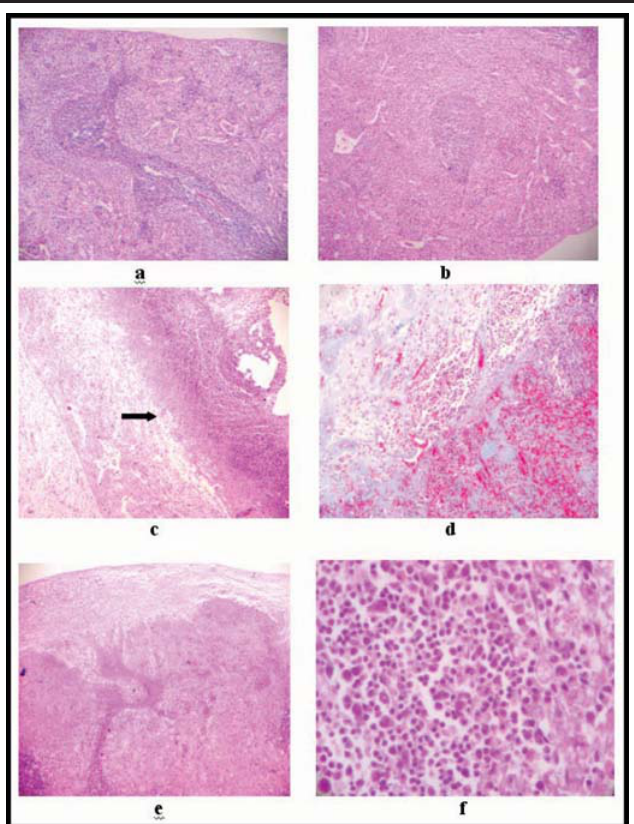
FIGURE 2 - Plasma lipid levels in animals submitted to spleen manipulation (Sim); to spleen implant (Imp) and to subtotal splenectomy with preservation of the inferior pole (STPI), not treated (n/HBO) and treated with hyperbaric oxygen therapy (w/HBO). Columns represent arithmetic means and bars above the columns, the standard deviations. PRE-pre-operation. MPO- mediate postoperation (11th post- operation day). *- p<0,05 relative to pre-operation; ** - p<0,01 relative to pre-operation